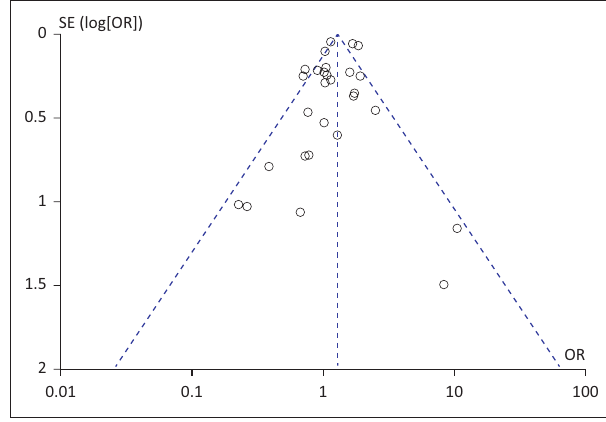
FIGURE 3: Bubble-plot for meta-regression. Meta-regression analysis showed that the association between HIV and mortality from COVID-19 was not affected by gender (a), CD4 cell count (b) or ART (c).